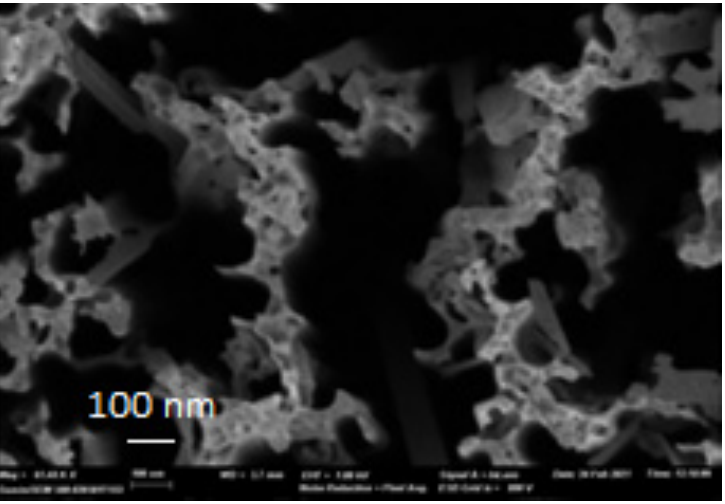
Figure 5. SEM surface image of 20 min MACE SiNWs decorated with PbS NPs . Table 1 . Concentration of chemical compositions determined from the EDX spectrum .